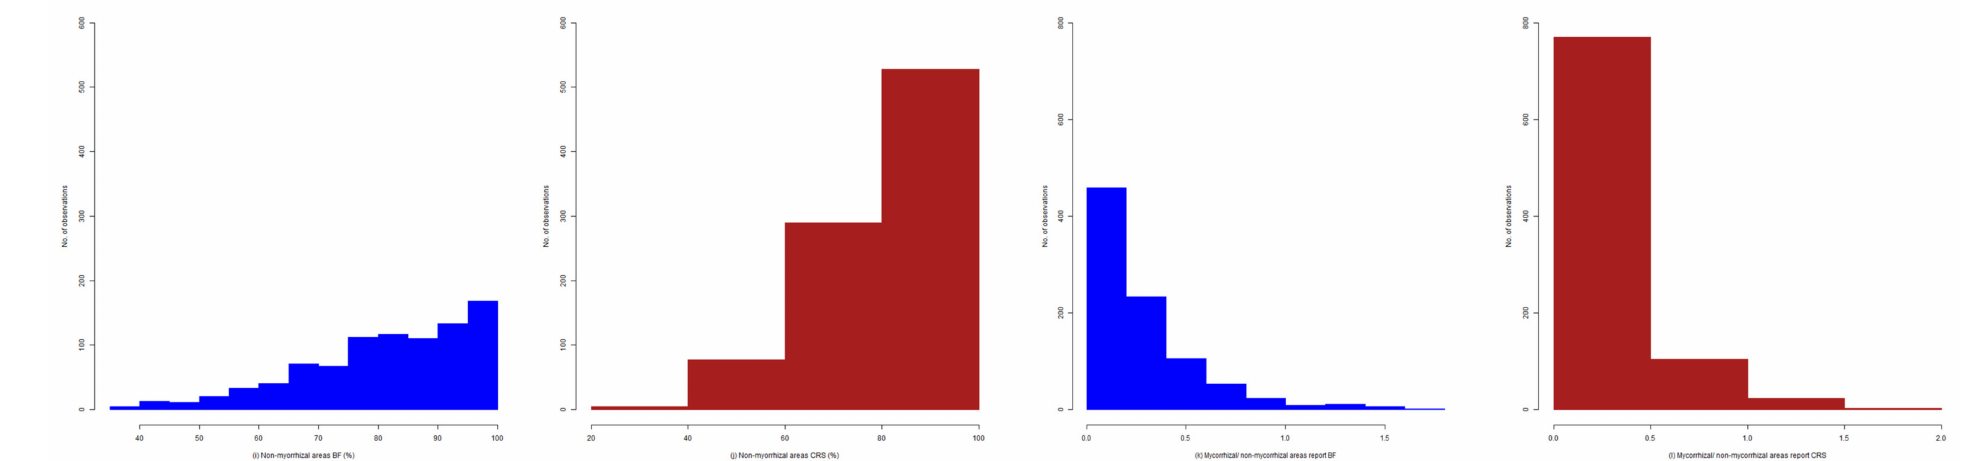
Figure 2. Histograms of colonization parameters. Each parameter was analyzed through two solutions: BF, best-fitted solution, given by the basic histogram formulas; CRS: frequency-class-restricted solution, given by the restriction of the frequency classes M1, low level (0–20%); M2, low–medium level (21–40%); M3, medium level (41–60%); M4, medium—high level (61–80%); and M5, high level (81–100%). ( a ) Frequency of colonization BF (%), ( b ) Frequency of colonization CRS (%), ( c ) Intensity of colonization BF (%), ( d ) Intensity of colonization CRS (%), ( e ) Arbuscules BF (%), ( f ) Arbuscules CRS (%), ( g ) Colonization degree BF (%), ( h ) Colonization degree CRS (%), ( i ) Non-mycorrhizal areas BF (%), ( j ) Non-mycorrhizal areas CRS (%), ( k ) Mycorrhizal/non-mycorrhizal areas report BF, ( l ) Mycorrhizal/non-mycorrhizal areas report